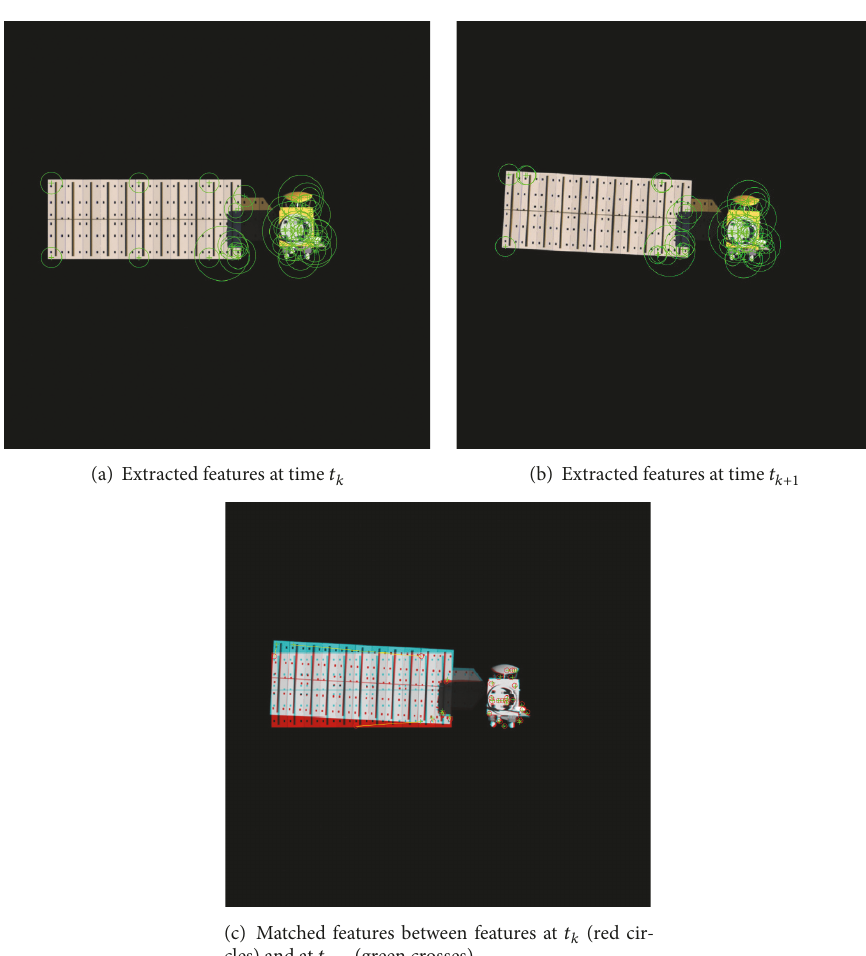
Figure 1: Features’ extraction and matching process between two subsequent